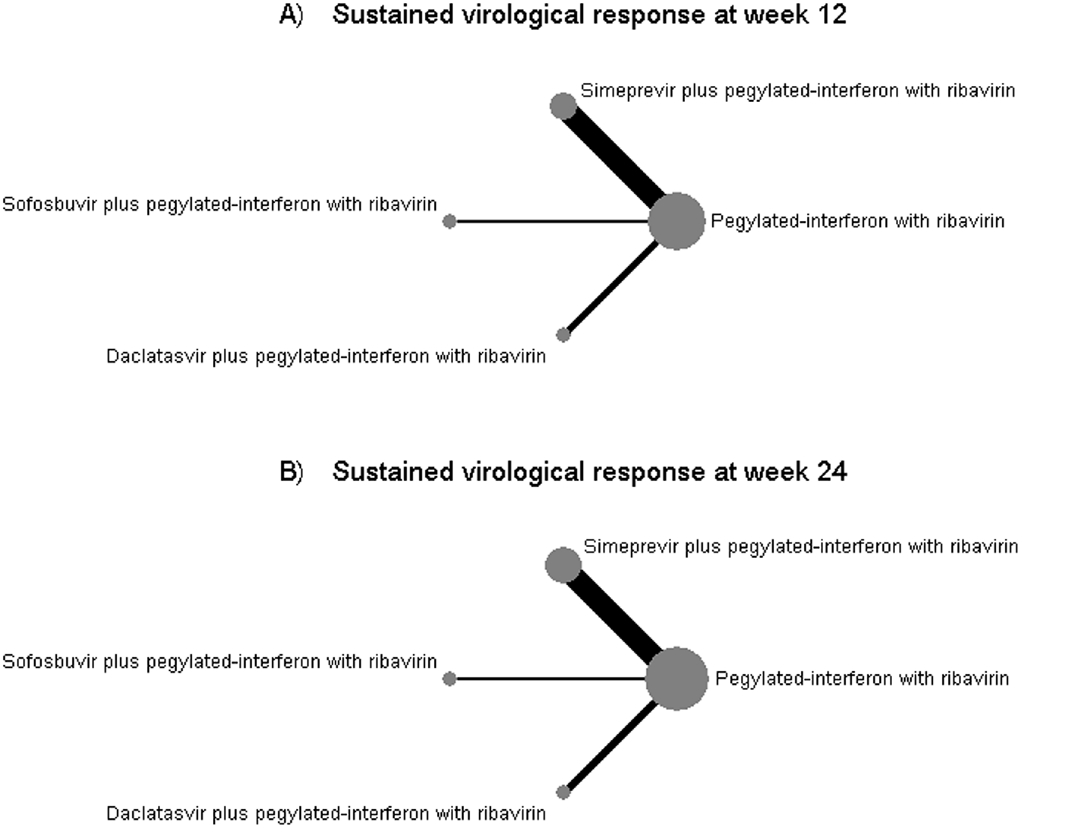
Fig 2. Network plots for sustained virological response at weeks 12 and 24 after the end of treatment.